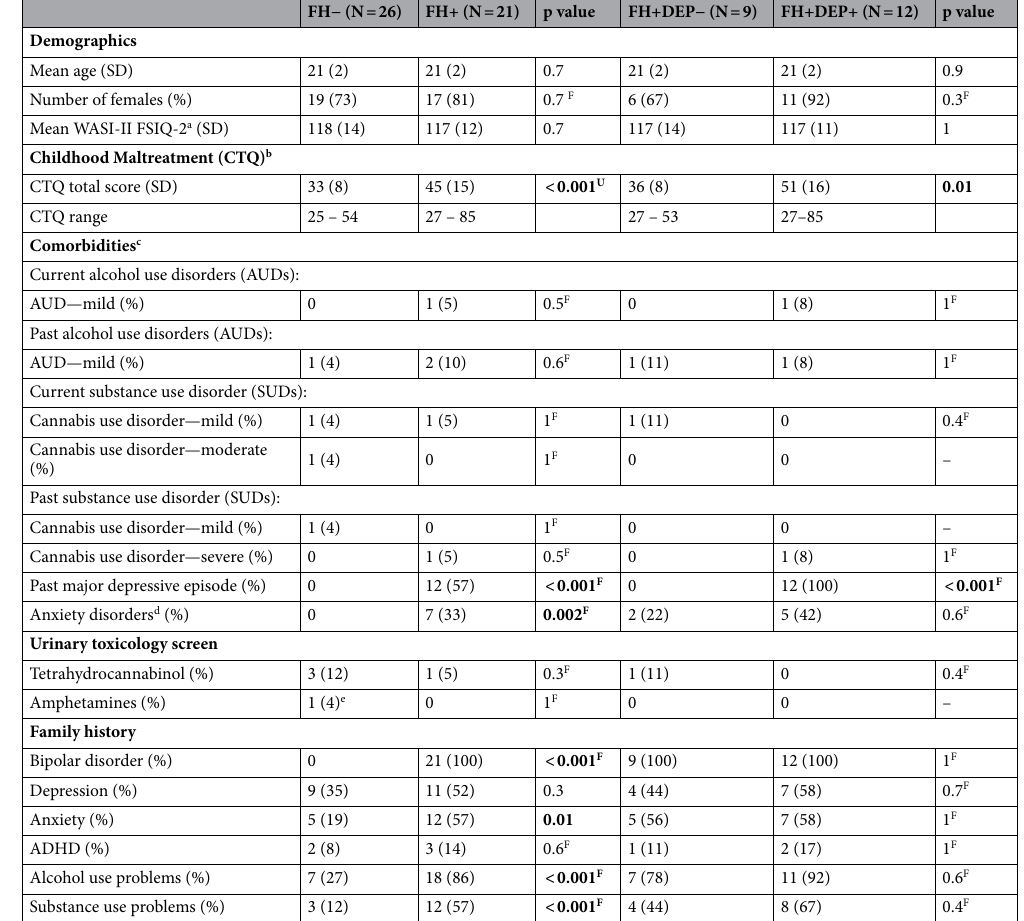
Table 1. Demographic, childhood maltreatment, and familial characteristics stratified by group. Entire sample [bipolar disorder family history negative (FH−) vs. bipolar disorder family history positive (FH+)] and FH+ subgroup [FH+ individuals without a history of unipolar depression (FH+DEP) vs. FH+ individuals with a history of unipolar depression (FH+ DEP+)] between-group differences in age, IQ, and CTQ were compared using a two-sample t-test. All other factors were examined with a Mann–Whitney Wilcoxon Test, Chi-square, or Fisher Exact tests, as appropriate. a FSIQ-2 represents the composite score for the full-scale intelligence quotient comprising verbal comprehension and matrix reasoning subtests on the Wechsler Abbreviated Scale of Intelligence-Second Edition (WASI-II). b Childhood Trauma Questionnaire. c No individuals presented with comorbid AUD and SUD. d Anxiety disorders included generalized anxiety disorder, specific phobia, panic disorder, and social anxiety disorder. e Individual who tested positive for amphetamines also tested positive for tetrahydrocannabinol. U Represents p-values calculated with Mann–Whitney Wilcoxon Test. F Represents p-values calculated with Fisher exact